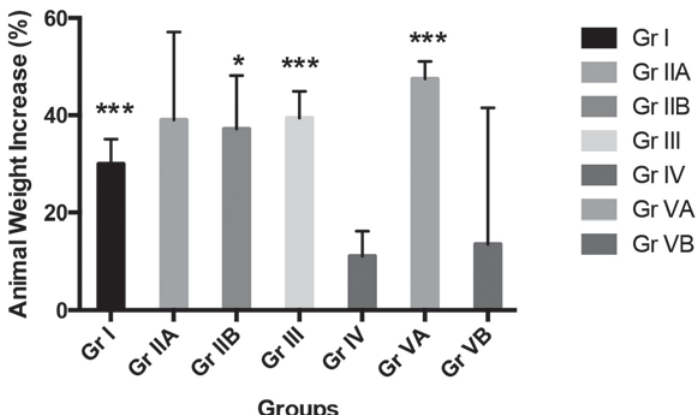
Figure 3- Results of the analysis of evolution of animal weights in percentage, which is the fraction of weight change from (cid:87)(cid:75)(cid:72)(cid:3)(cid:69)(cid:72)(cid:74)(cid:76)(cid:81)(cid:81)(cid:76)(cid:81)(cid:74)(cid:3)(cid:87)(cid:82)(cid:3)(cid:87)(cid:75)(cid:72)(cid:3)(cid:72)(cid:81)(cid:71)(cid:3)(cid:82)(cid:73)(cid:3)(cid:86)(cid:87)(cid:88)(cid:71)(cid:92)(cid:17)(cid:3)(cid:55)(cid:75)(cid:72)(cid:3)(cid:85)(cid:72)(cid:86)(cid:88)(cid:79)(cid:87)(cid:86)(cid:3)(cid:68)(cid:85)(cid:72)(cid:3)(cid:83)(cid:85)(cid:72)(cid:86)(cid:72)(cid:81)(cid:87)(cid:72)(cid:71)(cid:3)(cid:68)(cid:86)(cid:3)(cid:80)(cid:72)(cid:68)(cid:81)(cid:147)(cid:86)(cid:87)(cid:68)(cid:81)(cid:71)(cid:68)(cid:85)(cid:71)(cid:3)(cid:72)(cid:85)(cid:85)(cid:82)(cid:85)(cid:3)(cid:11)(cid:54)(cid:40)(cid:12)(cid:3)(cid:90)(cid:76)(cid:87)(cid:75)(cid:3)(cid:68)(cid:3)(cid:79)(cid:72)(cid:89)(cid:72)(cid:79)(cid:3)(cid:82)(cid:73)(cid:3)(cid:86)(cid:76)(cid:74)(cid:81)(cid:76)(cid:191)(cid:70)(cid:68)(cid:81)(cid:70)(cid:72)(cid:3)(cid:82)(cid:73)(cid:3)(cid:11)(cid:13)(cid:12)(cid:3)